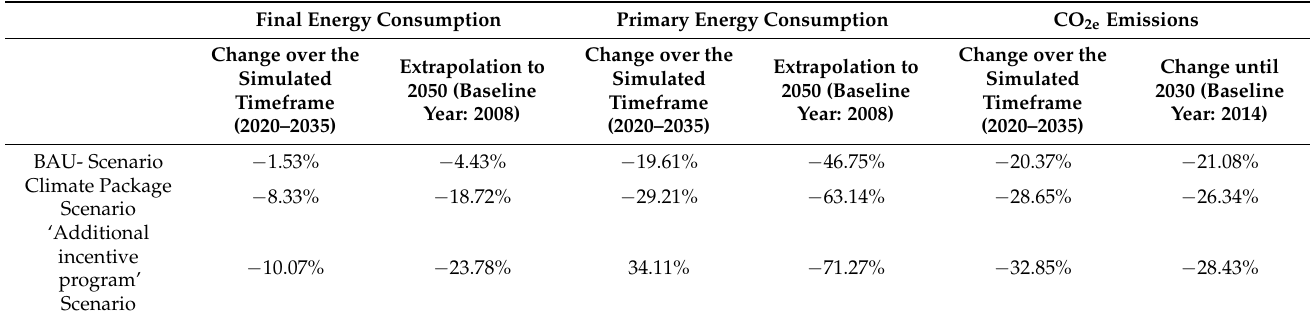
Table 1. Scenario results for final energy consumption, primary energy consumption and GHG emissions. Final Energy Consumption Primary Energy Consumption CO 2e Emissions Change over the